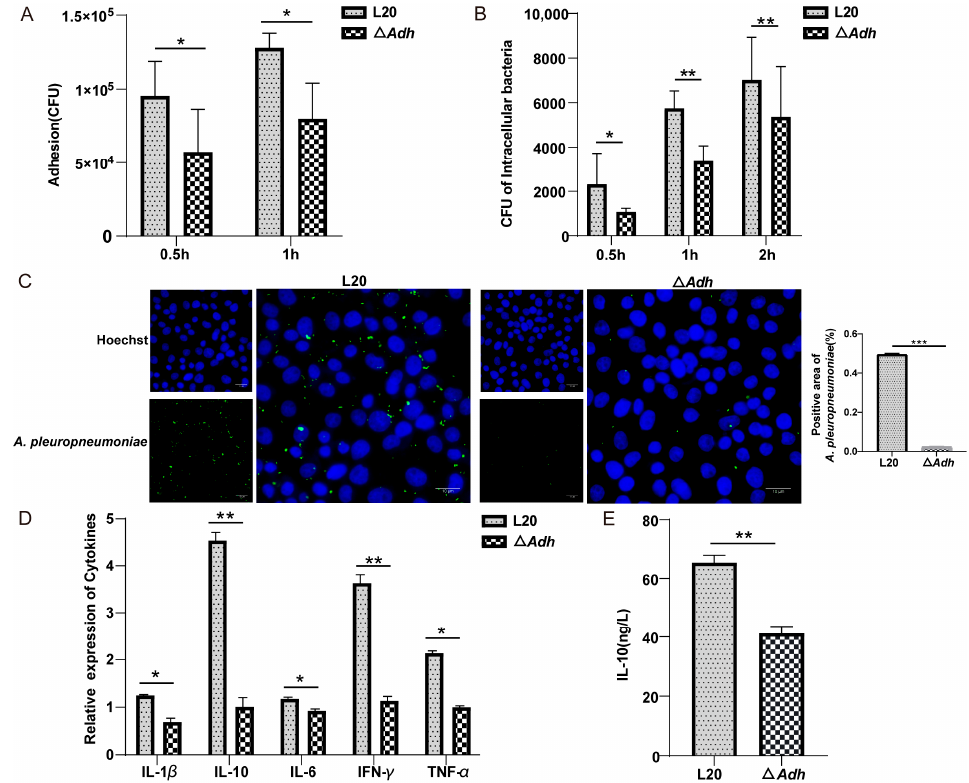
Figure 1. Adhesion ability, intracellular bacterial count of A. pleuropneumoniae strain L20, Adh deletion mutant ( ∆ Adh ), and cytokine expressions in PAM. ( A ) Adhesion assay. ( B , C ) The number of intracellular bacteria were counted using the plate method ( B ) and immunofluorescence analysis ( C ). ( D ) Expression of inflammation-associated cytokines in PAM infected with L20 or ∆ Adh . ( E ) IL-10 secretion of PAM was detected by ELISA. Multiple t -test and t -test. * p < 0.05, ** p < 0.01, ***, p <